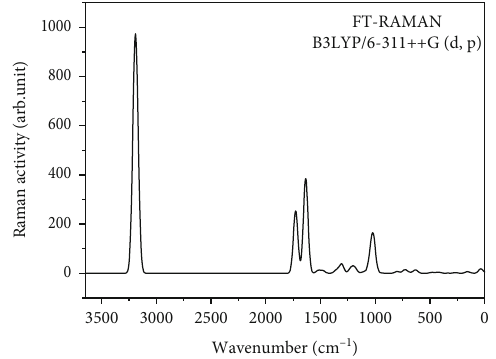
Figure 3: FT Raman spectrum of